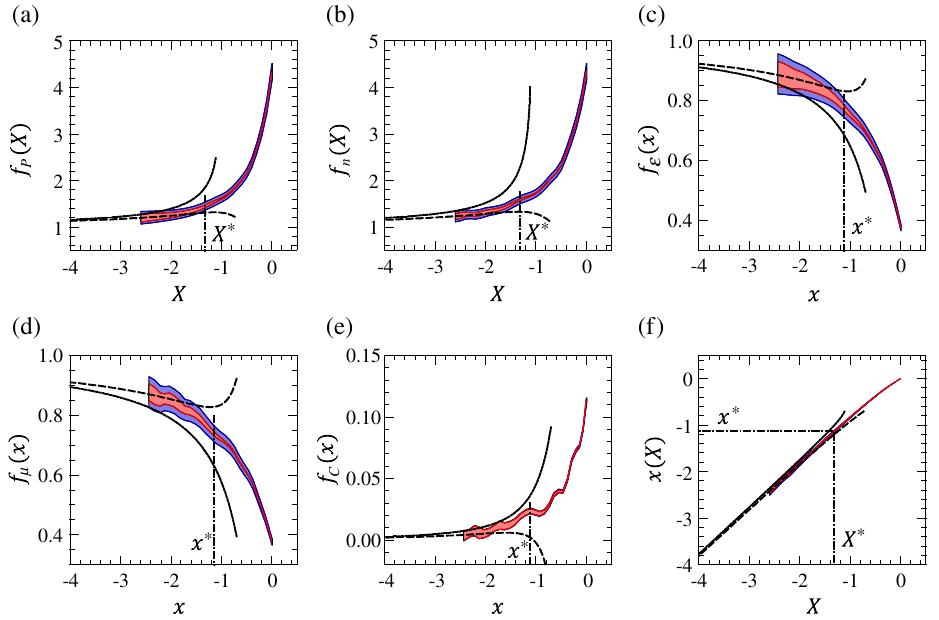
FIG. 5. Dimensionless thermodynamic functions derived from G ð χ Þ . (a) Pressure. (b) Number density. (c) Internal energy density. (d) Chemical potential. (e) Contact density. (f) Canonical interaction parameter. The red colors indicate ranges of statistical errors caused by the uncertainty of the offset value of G ð χ Þ . The blue colors indicate additional statistical errors resulting from the uncertainty of the absorption cross section. The dotted curves and the dashed curves show their asymptotic behavior at the BCS limit up to the first and second order of 1 =x , respectively. The vertical dash-dotted lines indicate interaction parameters X (cid:4) and x (cid:4) where superfluid transition occurs. The Fermi system is in the superfluid state in the region of X > X (cid:4) or x > x (cid:4) .